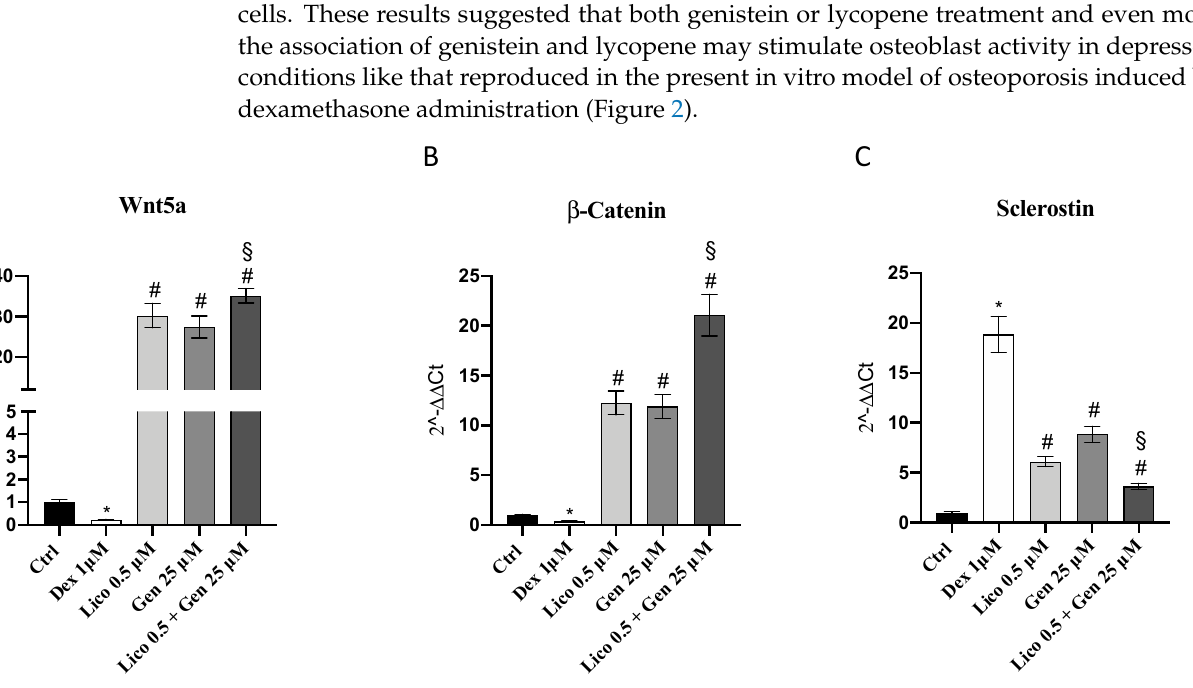
Figure 1. The graphs ( A – C ) represent b-ALP, RUNX-2, and NRF2 mRNA expression evaluated by q-PCR in primary osteoblasts treated with lycopene or genistein or lycopene and genistein following dexamethasone challenge for 24 h. The figures ( E – I ) show Alizarin Red S staining; primary osteoblasts incubated with dexamethasone for 24 h exhibit a reduction of mineralized matrix formation, demonstrated by the red color attenuation ( F ); cells treated with lycopene, genistein, and their association are characterized by a strong alizarin red accumulation, resulting from an increased mineralized matrix formation ( G – I ). Panel ( D ) shows the % of Mineralization Area evaluated in primary osteoblasts through Alizarin Red staining. The data are expressed as the means and SD. *